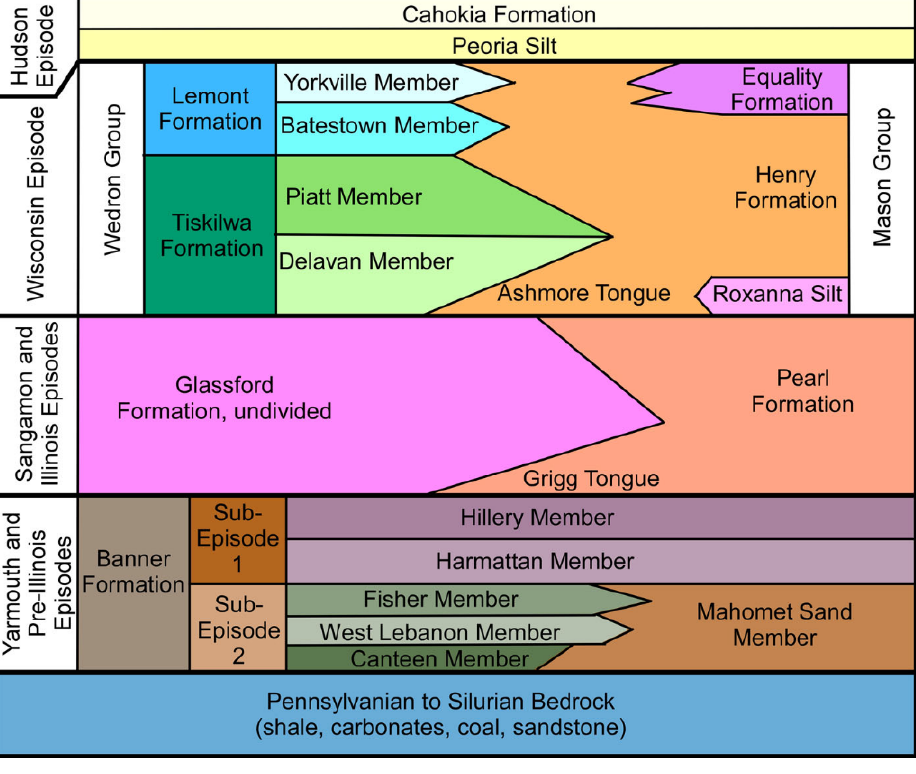
Figure 2. Generalized lithostratigraphy of Quaternary-age sediments in east-central Illinois. All units that rest unconformably above the bedrock strata are Quaternary in age. Modified from [39] .